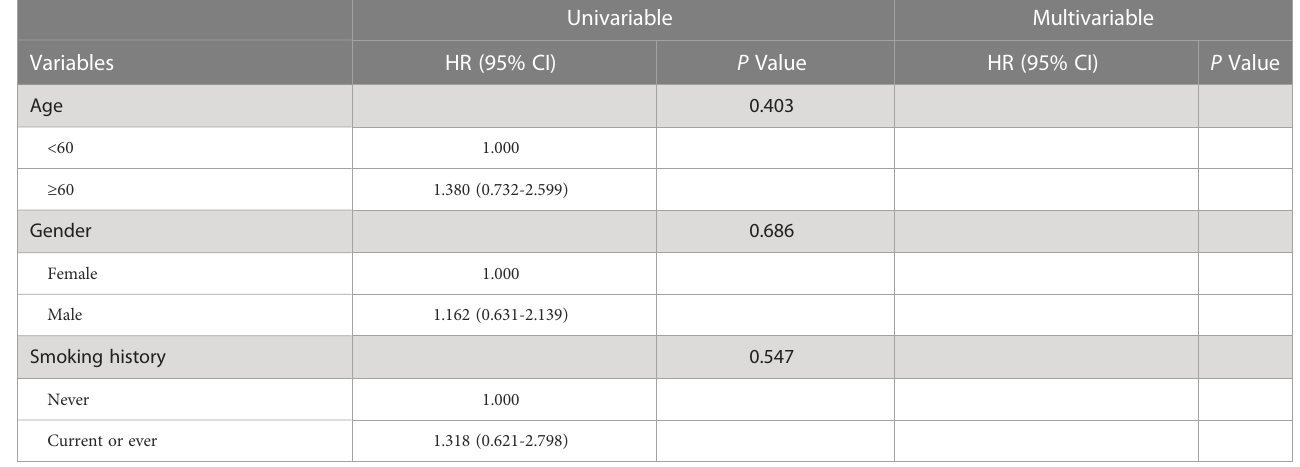
TABLE 4 Univariate and multivariate Cox regression analysis for PFS in patients with receiving EGFR -TKIs. Univariable Multivariable Variables HR (95% CI) P Value HR (95% CI) P Value